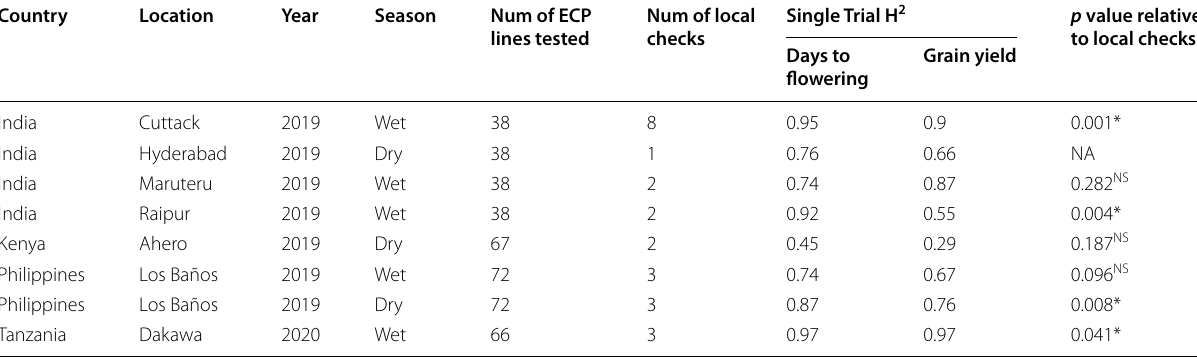
Table 4 Summary of agronomic trials conducted in target environments to evaluate the performance of the elite core panel